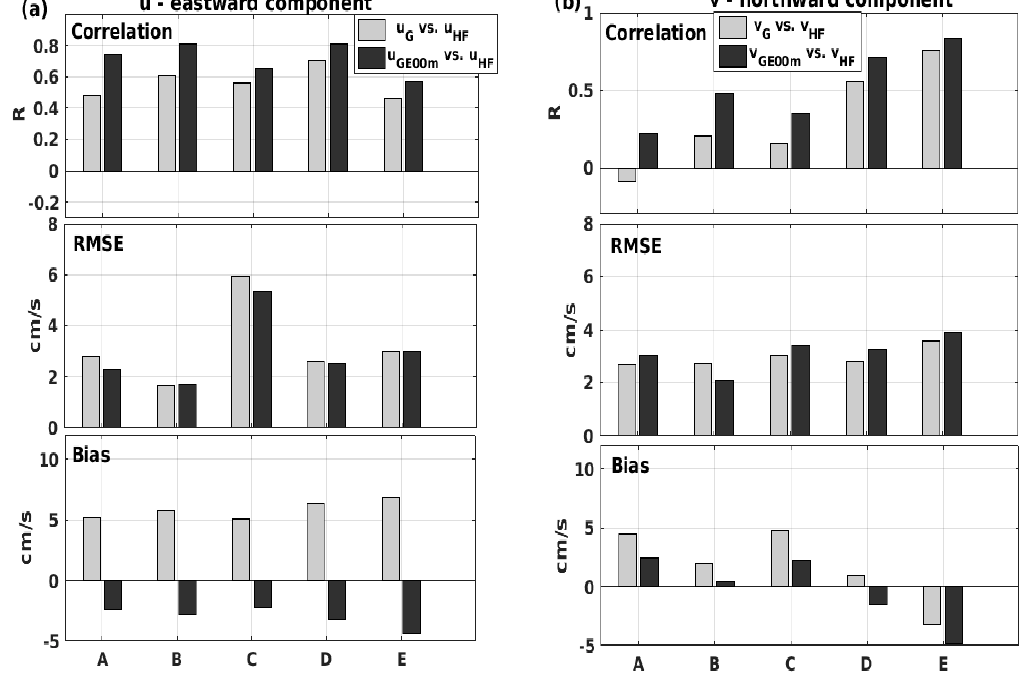
Figure 10. Statistical measures of R, RMSE, and Bias (top to bottom) between MAB GlobCurrent and in situ HF radar U HF data for ( a ) the eastward component and ( b ) the northward component at the selected focus areas A-E labeled in X-axis (see Figure 1). Results given for both GC U G vs. U HF (in gray) and U GE00m vs. U HF (in black).